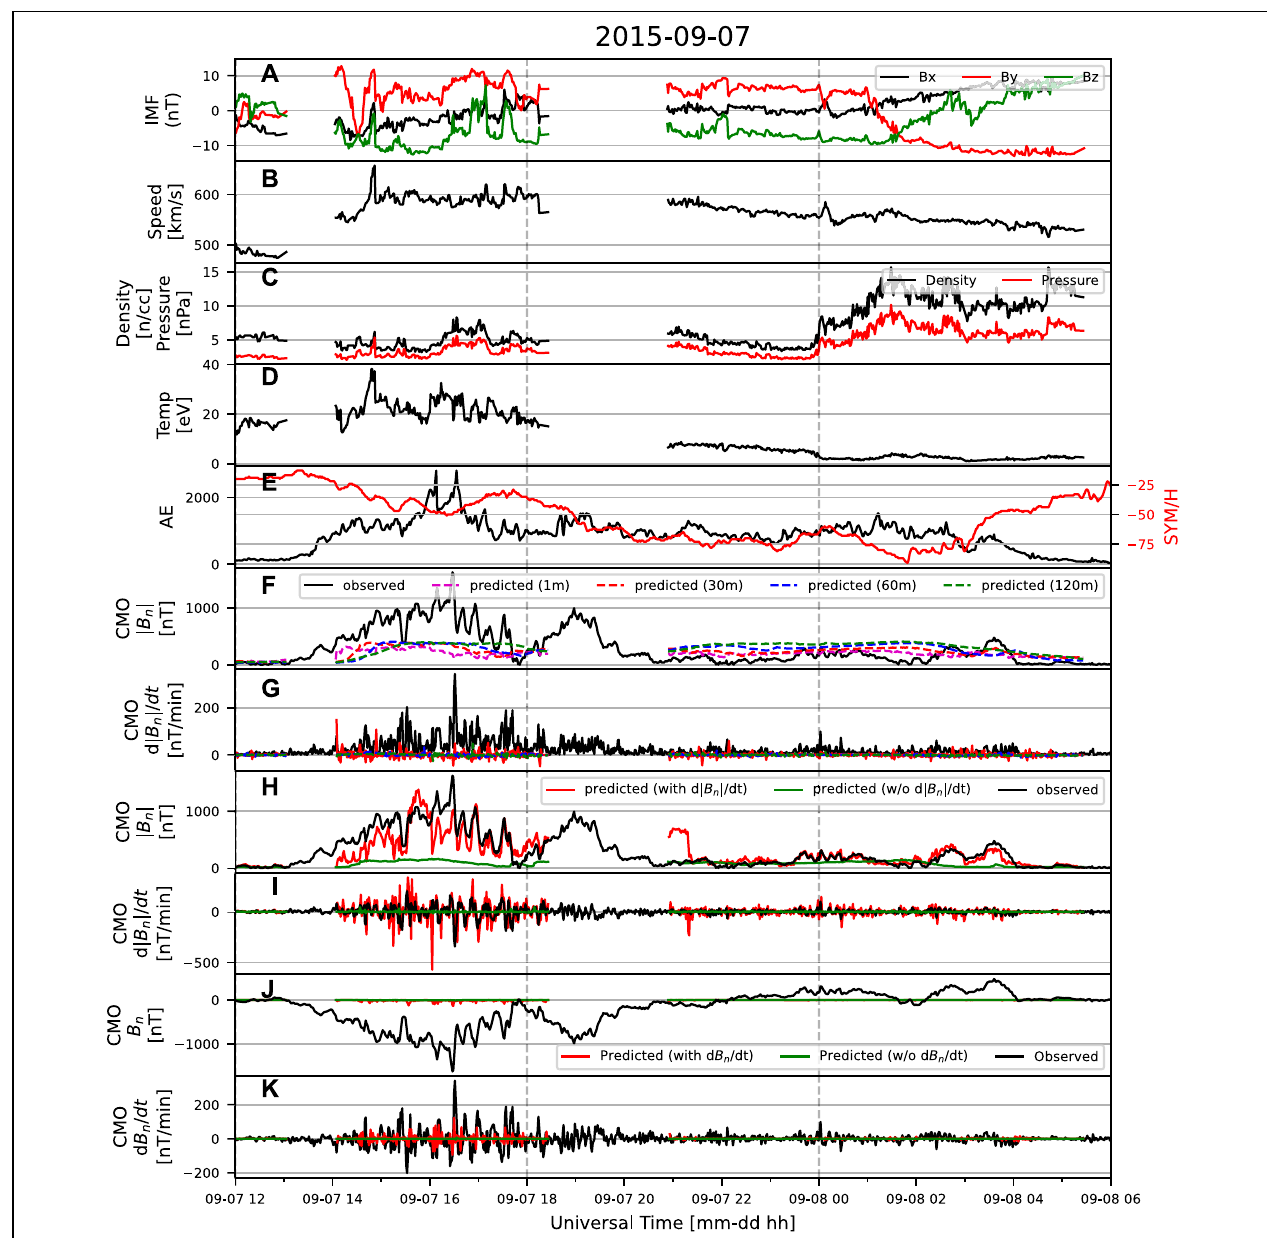
FIGURE 2 | Storm time test predictions of different LSTM configurations for the 07-Sep-2015 storm. Subplots (A–E) show the IMF, solar wind, and geomagnetic indices conditions with the model predictions in the subplots beneath. Subplots (F,G) show the results of predictions utilizing different time histories of input. From these we see the 1-min time history model consistently predicts values less than that of the other 3 models. Subplots (H,I) show the results of predicting for | B N | utilizing the 30-min time history both with and without d | B N | /dt as an input parameter. Likewise, subplots (J,K) utilize the 30-min time history model to predict B N with and without d B N /dt information added as input. From these plots we find that LSTM has an affinity for predicting | B N | with d | B N | /dt information included in the input